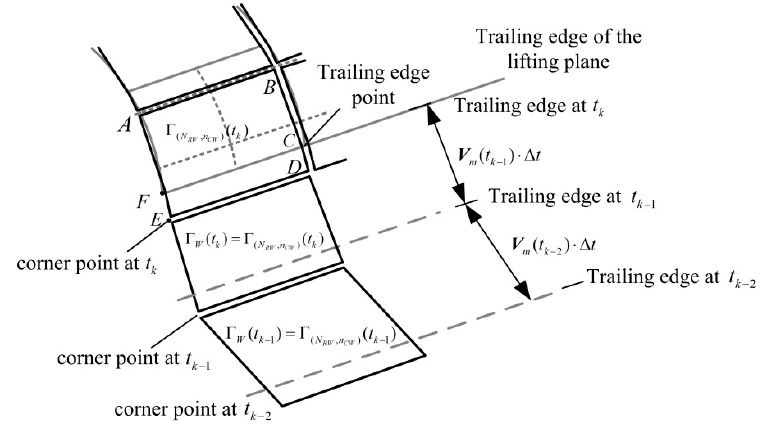
Figure 3. Non-planar unsteady vortex ring modeling.